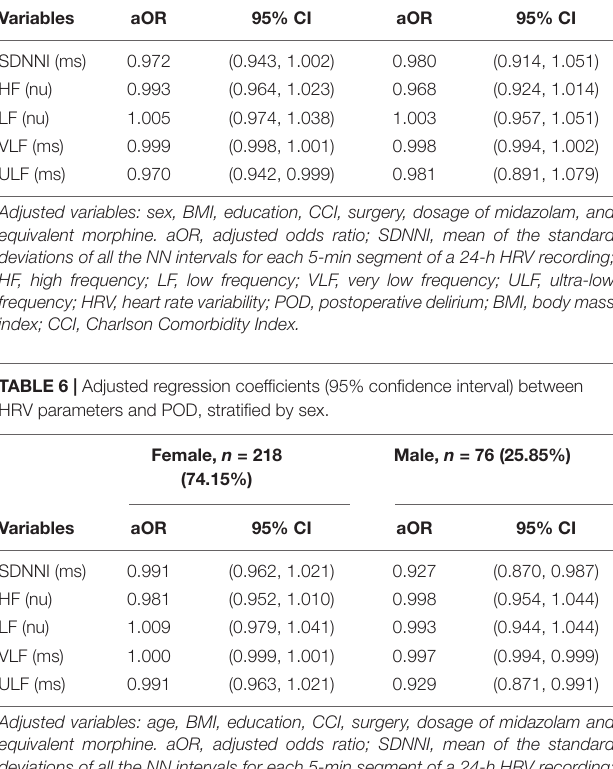
TABLE 5 | Adjusted regression coefficients (95% confidence interval) between HRV parameters and POD, stratified by age. Young-old, n = 251 (85.37%)